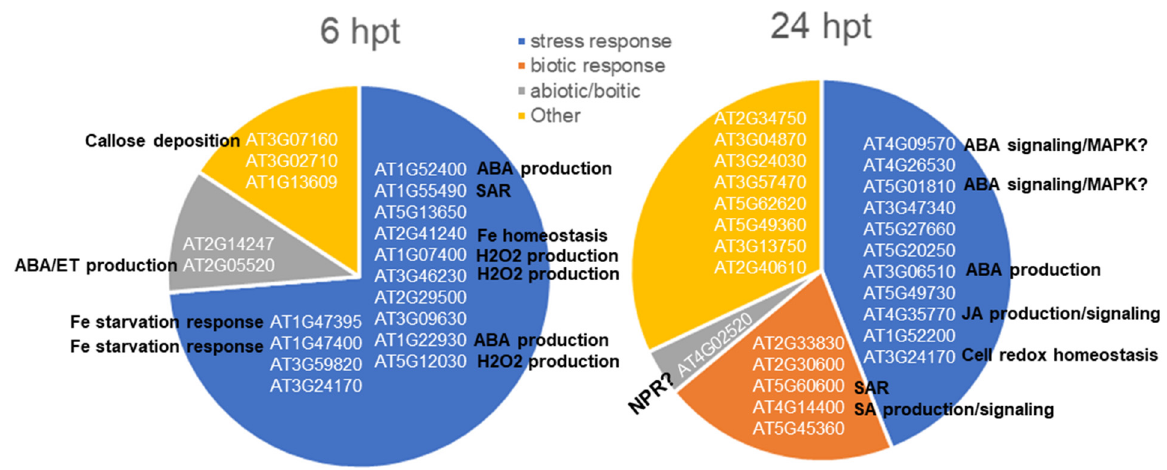
Figure 4. Upregulated DEGs in Arabidopsis Col-0 at 6 and 24 hpt with SSG at FDR < 0.001 determined by EdgeR analysis. Functional categorization of the genes is based on GO annotation on TAIR (The Arabidopsis Information Resource). The DEGs functions involving defense priming are bold.